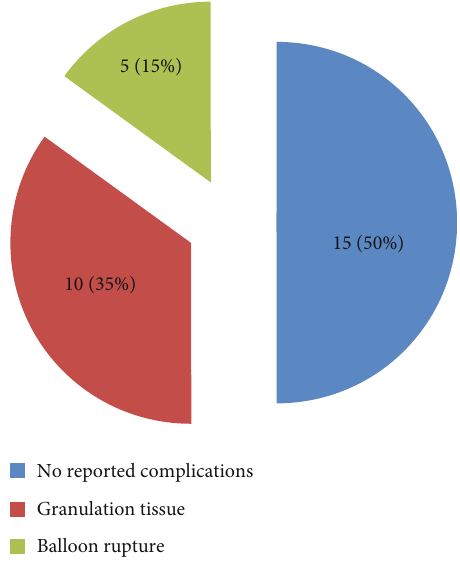
Figure 4: Complications associated with gastrostomy tube